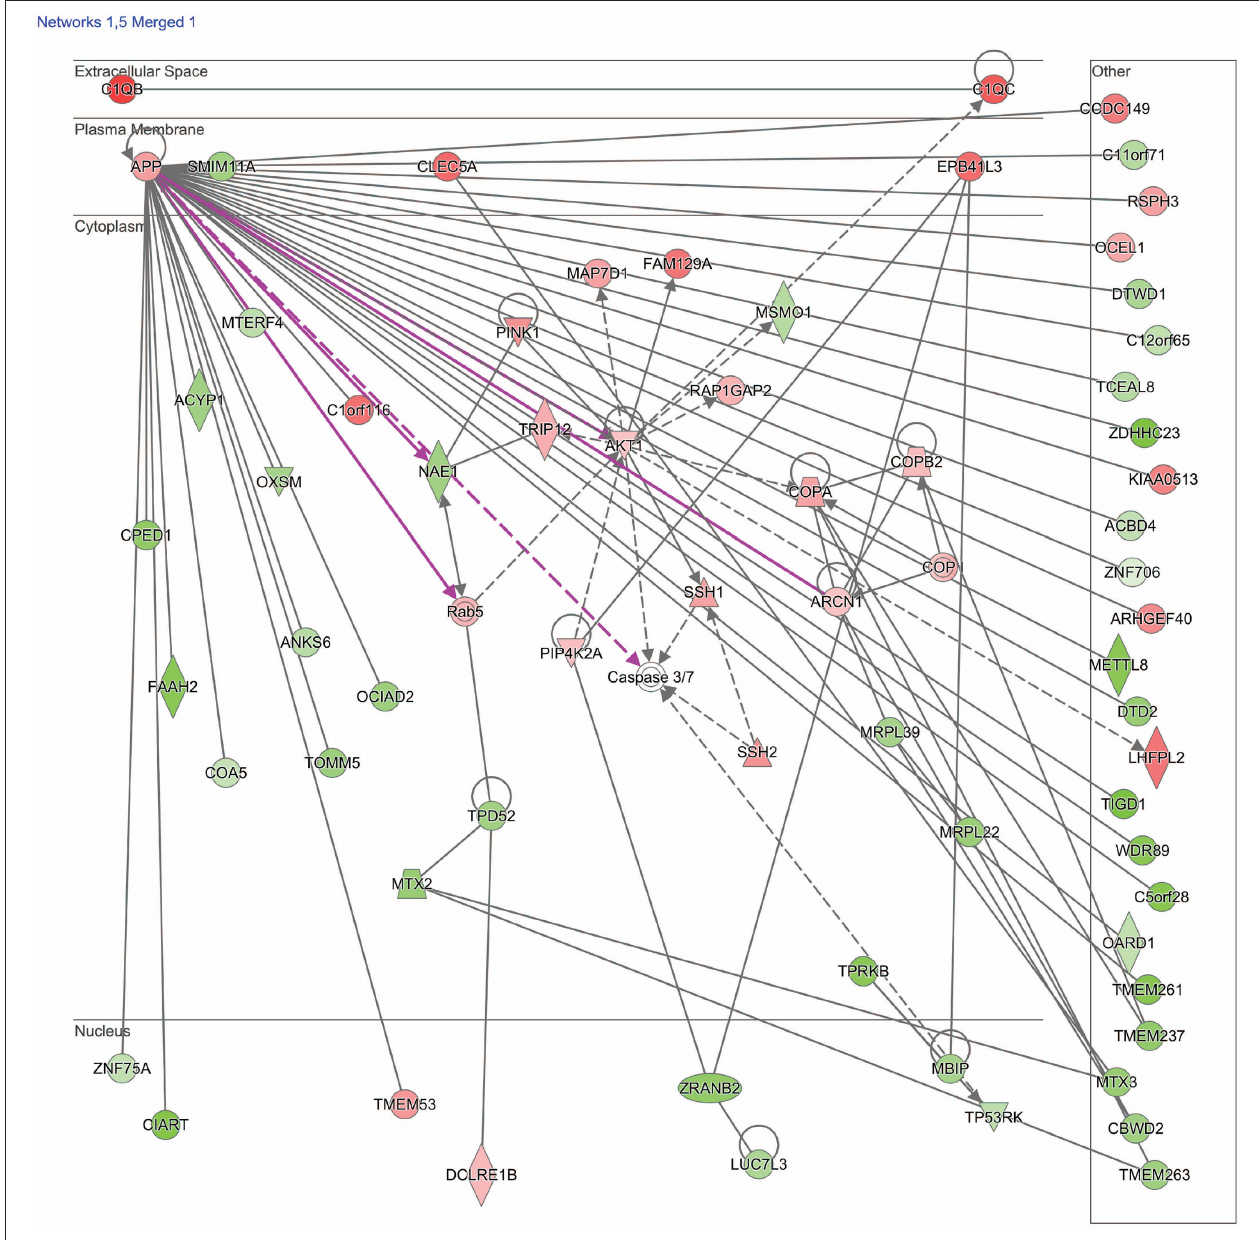
FIGURE 2 | Network shows dysregulated structure, function, and development pathway following moderate blast. Genes described in the text include: TRIP12, NAE1, AKT1, MBIP, COA5 , and EPB41L3 . Red indicates increased measurement; green represents decreased measurement; with increased color saturation representing more extreme measurement in dataset. Solid lines represent direct interactions, non-targeting interactions, or correlations between chemicals, proteins, or RNA. Dotted lines represent indirect interactions. Purple lines denote the commonly found relationship among the two merged networks. Arrowed lines represent activation, causation, expression, localization, membership, modification, molecular cleavage, phosphorylation, protein-DNA interactions, protein-RNA interactions, regulation of binding, transcription. Shapes represent molecule type (double circle, complex/group; square, cytokine; diamond, enzyme; inverted triangle, kinase; circle, other; triangle, phosphatase; oval, transcription regulator; trapezoid, transporter). The network was generated through the use of IPA (QIAGEN Inc., https:// www.qiagenbioinformatics.com/products/ingenuity-pathway-analysis).